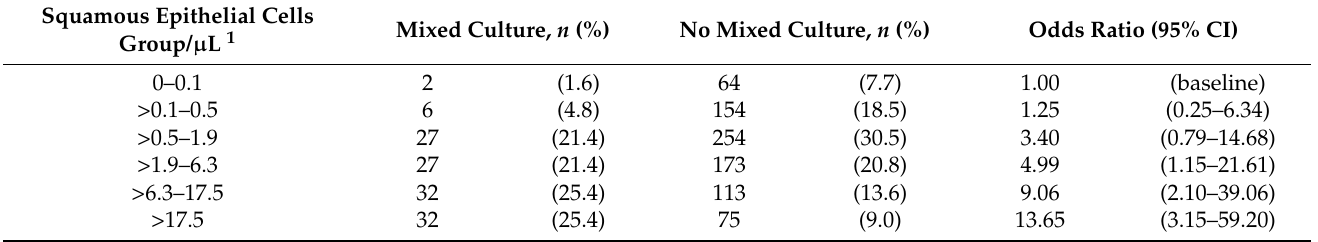
Table 2. Univariable association of squamous epithelial cells and mixed culture in the validation set using logistic regression analysis.